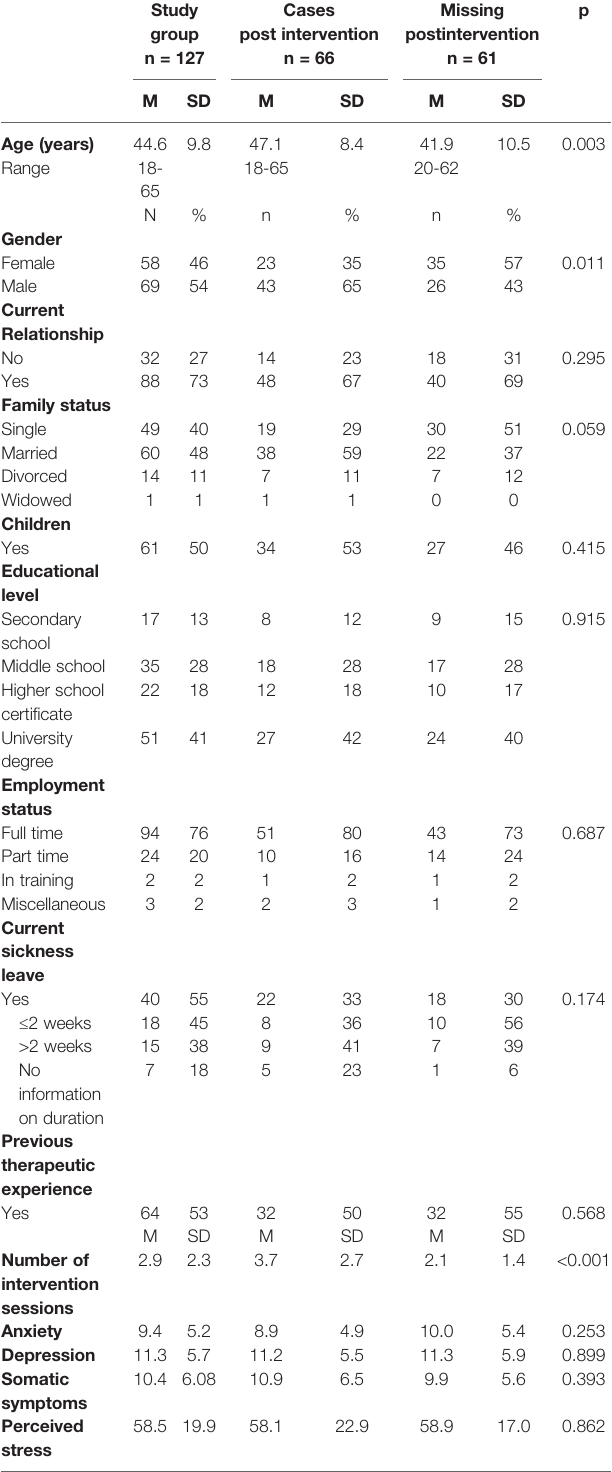
TABLE 1 | Sociodemographic and clinical characteristics of the study sample. Study